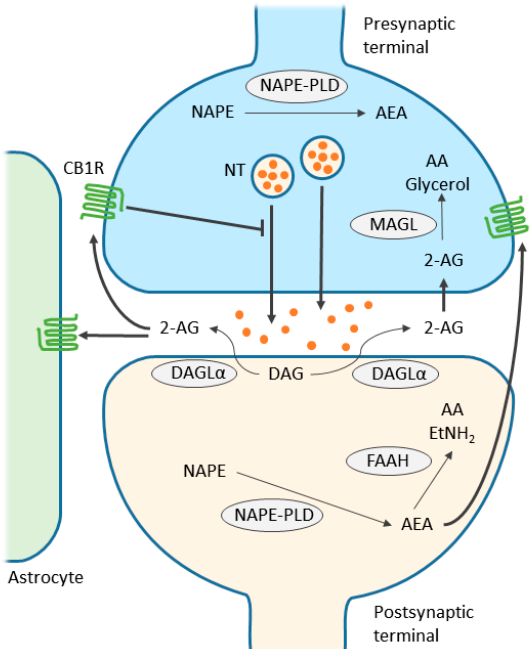
Figure 1. Simplified scheme representing endocannabinoid retrograde signaling mediated synaptic transmission. Endocannabinoids are produced from postsynaptic terminals upon neuronal activation. As the two major endocannabinoids shown in the scheme, 2-arachidonolglycerol (2-AG) is biosynthesized from diacylglycerol (DAG) by diacylglycerol lipase- α (DAGL α ), and anandamide